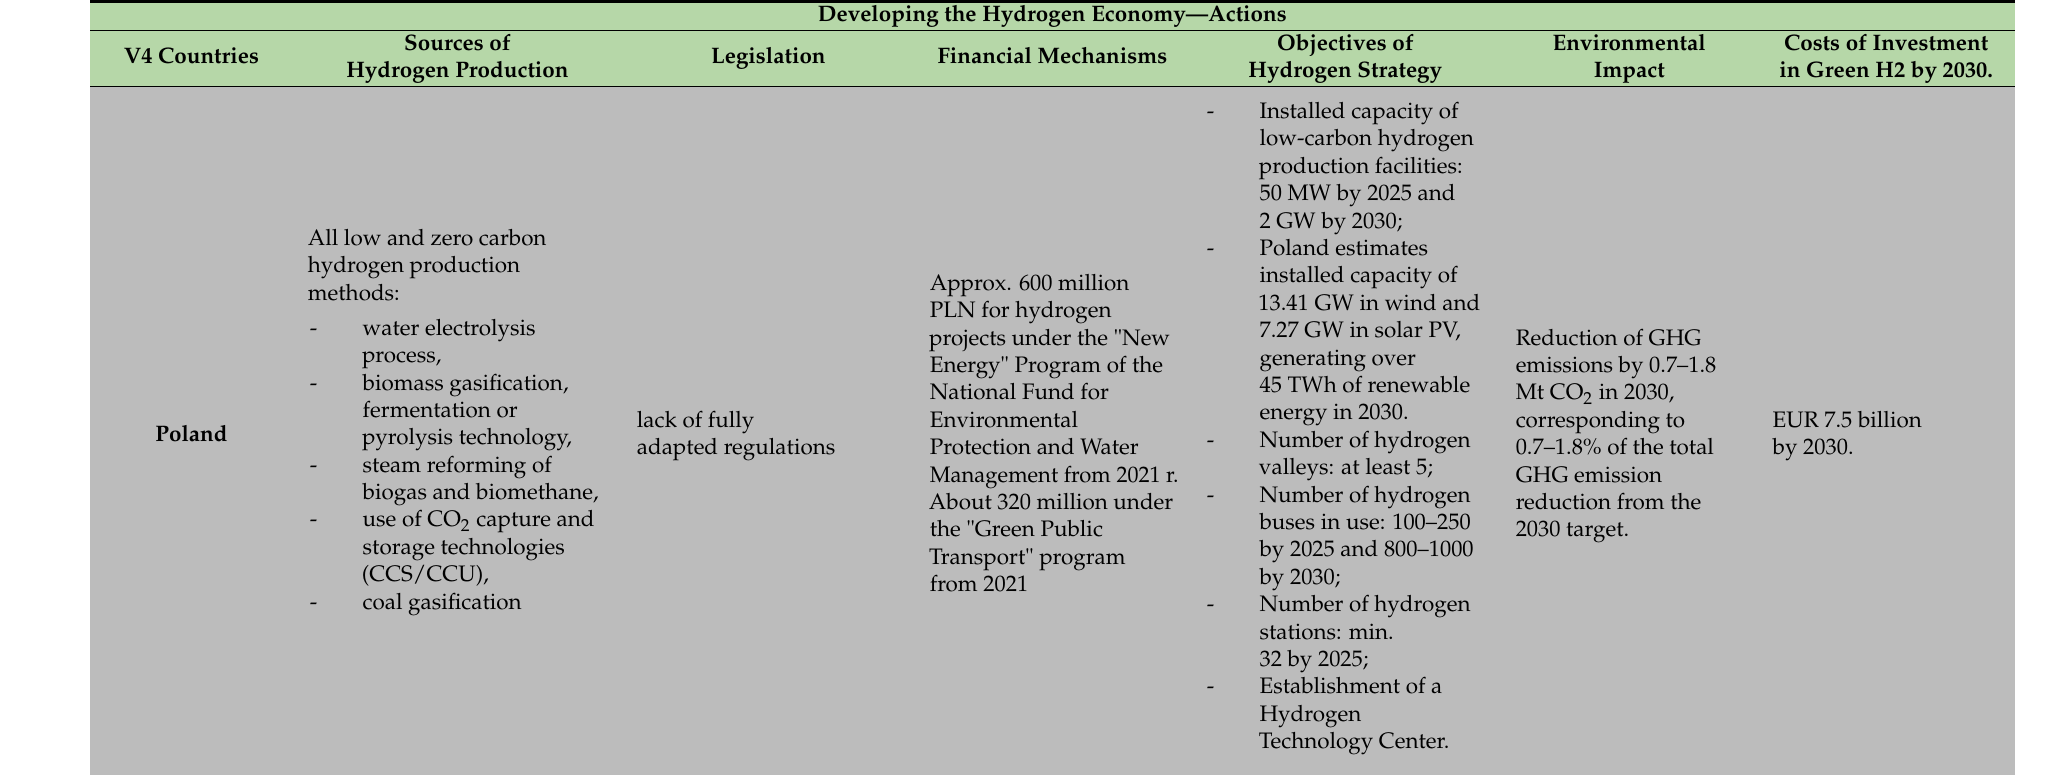
Table 1. Actions taken to develop the hydrogen economy in the Visegrad